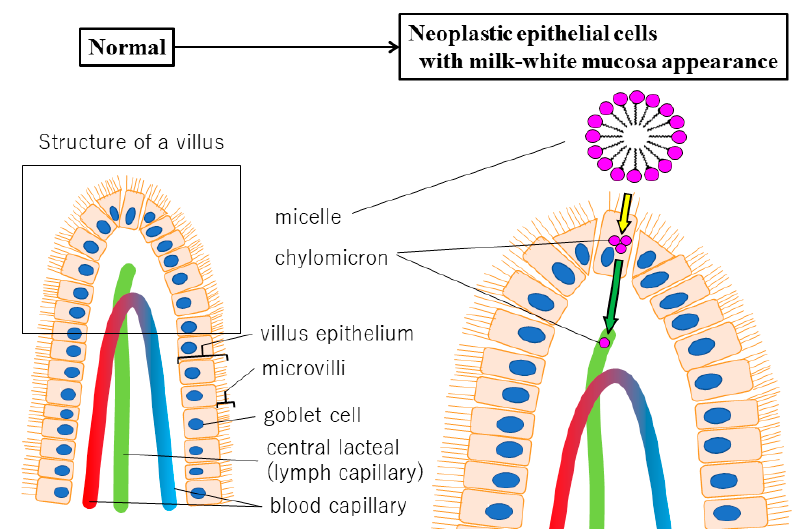
Figure 5. Duodenum normal villus histological structure and lipid accumulation based on the dysfunctional transport hypothesis.